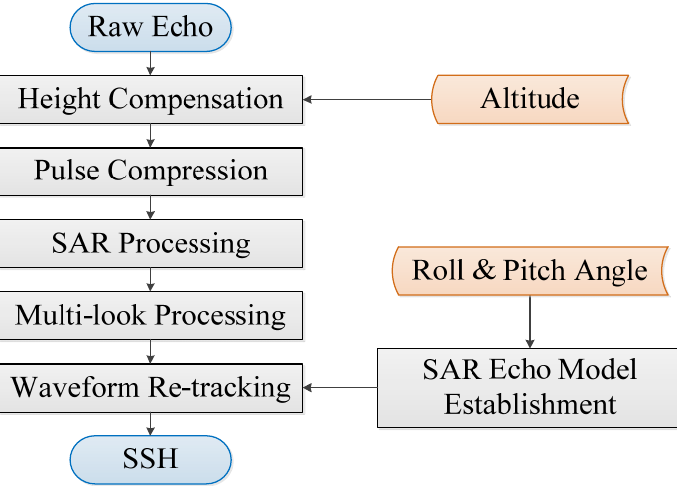
Figure 5. Flowchart of the airborne data processing procedure.